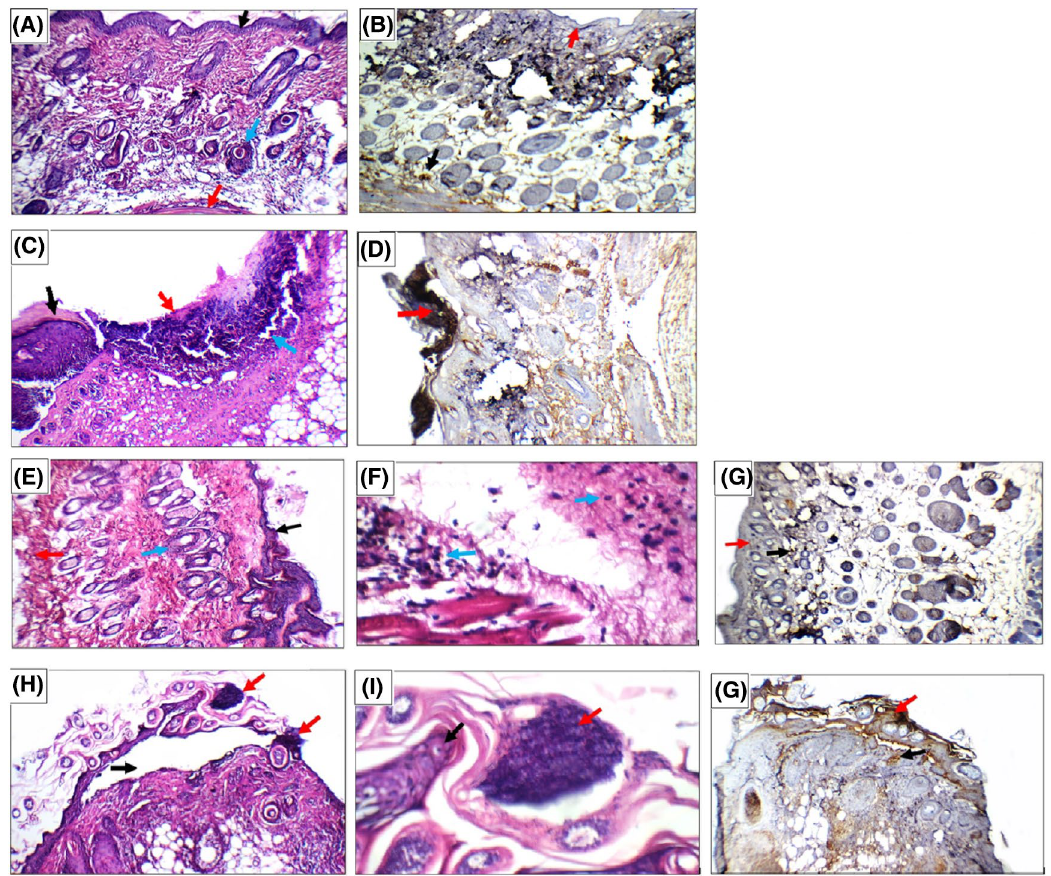
Figure 5. ( A , B ) Representing the negative control group skin sections; where ( A ) skin showing average epidermis (black arrow), average dermis with pilo-sebaceous units (blue arrow) and average deep dermis (red arrow) (H&E × 200), ( B ) skin showing positive nuclear reactivity (0) for ki67 in less than 5% in epidermis (red arrow) and in dermis (black arrow) (ki67 immunostain × 200). ( C, D ) Representing the positive control group skin sections; where ( C ) skin showing healthy area (black arrow), and another area of ulceration with infiltrating tumor (red arrow) reaching the deep dermis (blue arrow) (H&E × 200), ( D ) skin showing strong nuclear reactivity (+ +) for ki67 in more than 50% of tumor cells (red arrow) (ki67 immunostain × 200). ( E , F , and G ) Representing nobiletin composite PEVs (F13) treated group III skin sections; where ( E ) skin showing intact epidermis (black arrow), average superficial dermis with pilo-sebaceous units (blue arrow) and average deep dermis (red arrow) (H&E × 200), ( F ) Another view showing average deep dermis with mild inflammatory infiltrate (blue arrow) (H&E X 400), ( G ) Skin showing positive nuclear reactivity (0) for ki67 in less than 5% in epidermis (red arrow) and in dermis (black arrow) (ki67 immunostain × 200). ( H , I , and J ) Representing nobiletin solution treated group skin sections;where ( H ) skin showing detached epidermis (black arrow) with overlying tumor infiltrating superficial dermis (red arrow) (H&E × 200), ( I ) high power view showing epidermis (black arrow) with overlying tumor composed of markedly pleomorphic small cells with hyperchromatic nuclei (red arrow) (H&E × 400), ( J ) skin showing positive nuclear reactivity (0) for ki67 in less than 10% in epidermis (red arrow) and dermis (black arrow) (ki67 immunostain ×